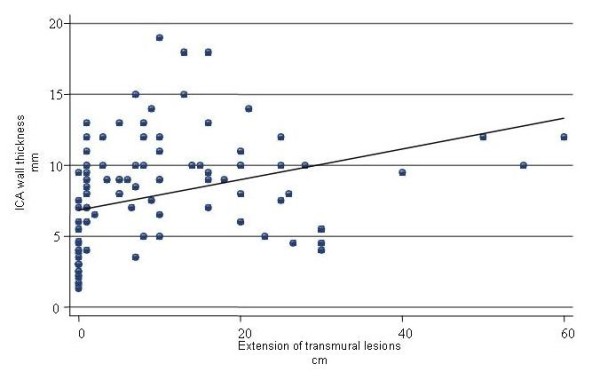
Scatter plot of pairs of US values of the extension of intramural lesions at the level of the neo-terminal ileum and the wall thickness at level of the ileo-colonic anastomosis in 111 evaluations (58 patients) and estimated correlation.